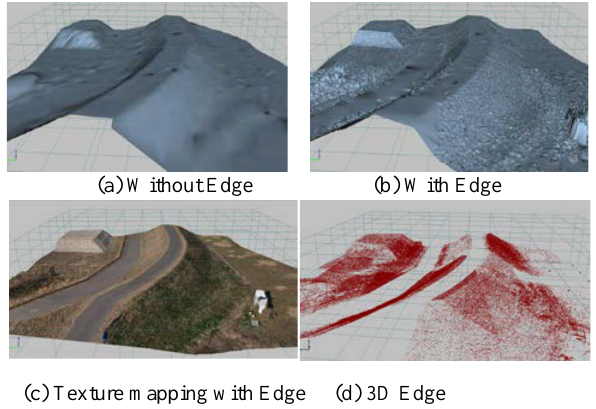
Figure 10. Measurement by UAV